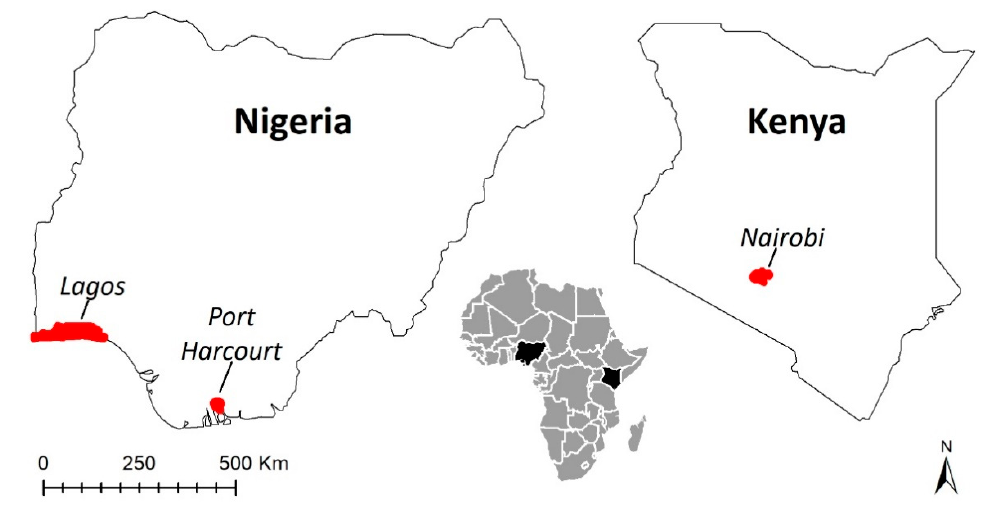
Figure 1. Map of three study cities.